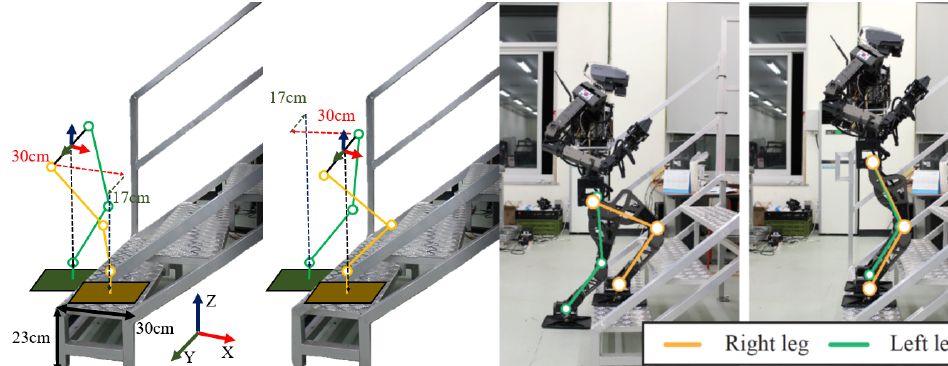
Figure 10. Snapshots of stair climbing test.